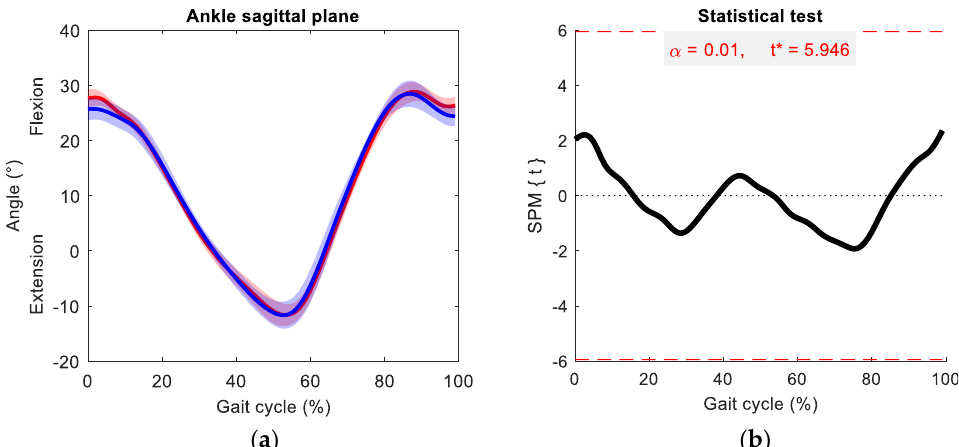
Figure 9. ( a ) Mean sagittal hip angle during gait cycle from heel strike to heel strike with (red) and without (blue) exosuit, and ( b ) statistical 1D SPM test; * critical t-value.